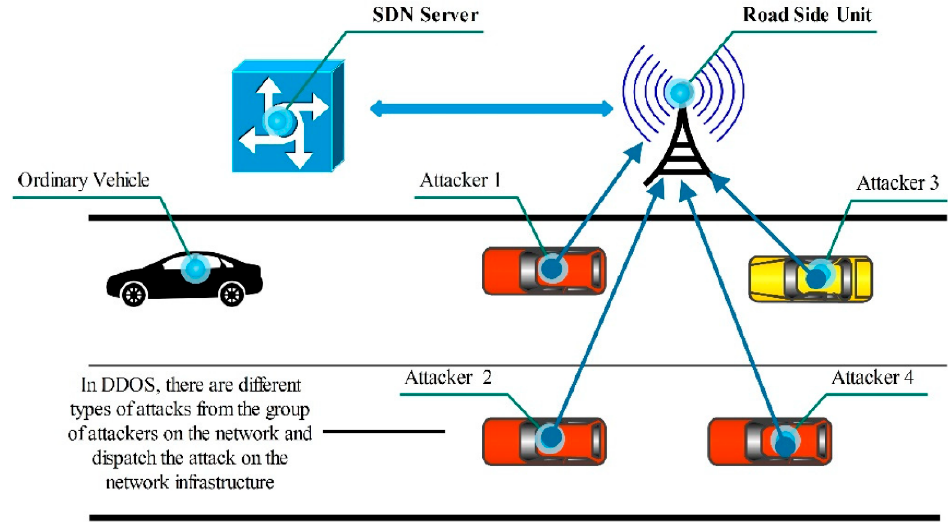
Figure 1. DDoS Attack on vehicles in the VANET environment [12].